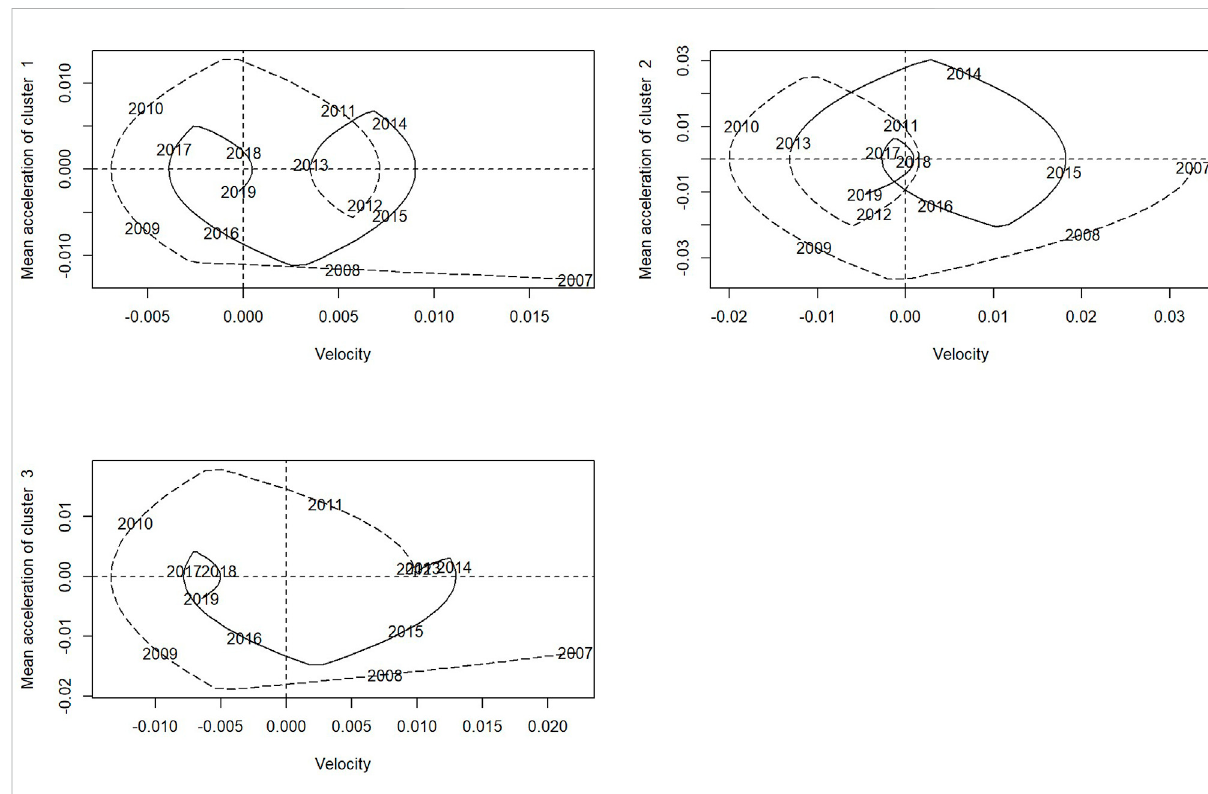
FIGURE 8 Phase diagram of the mean function of the re-electri fi cation index of three